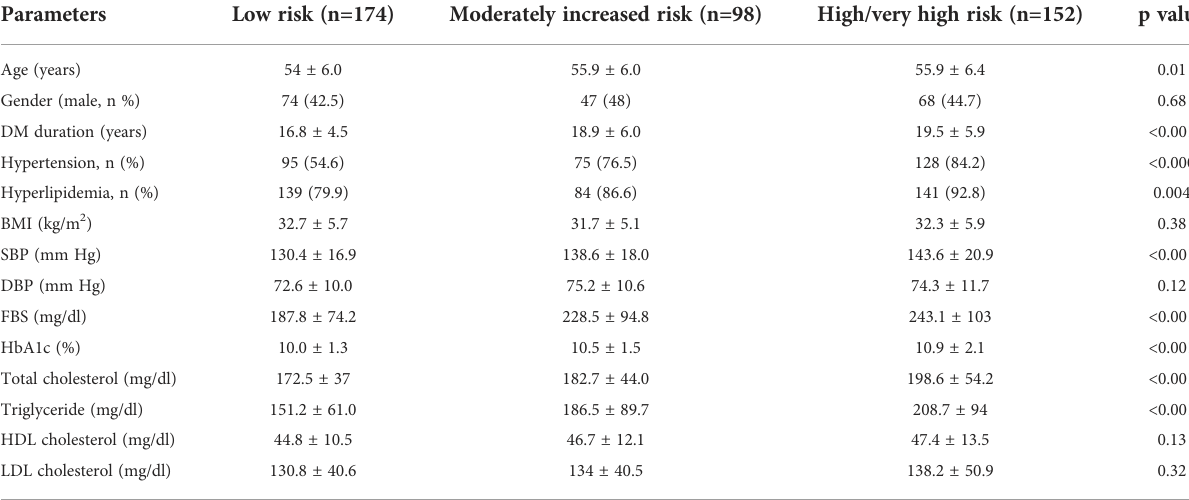
TABLE 1 Demographic and clinical characteristics of patients with type 2 diabetes according to KDIGO classi fi cation.